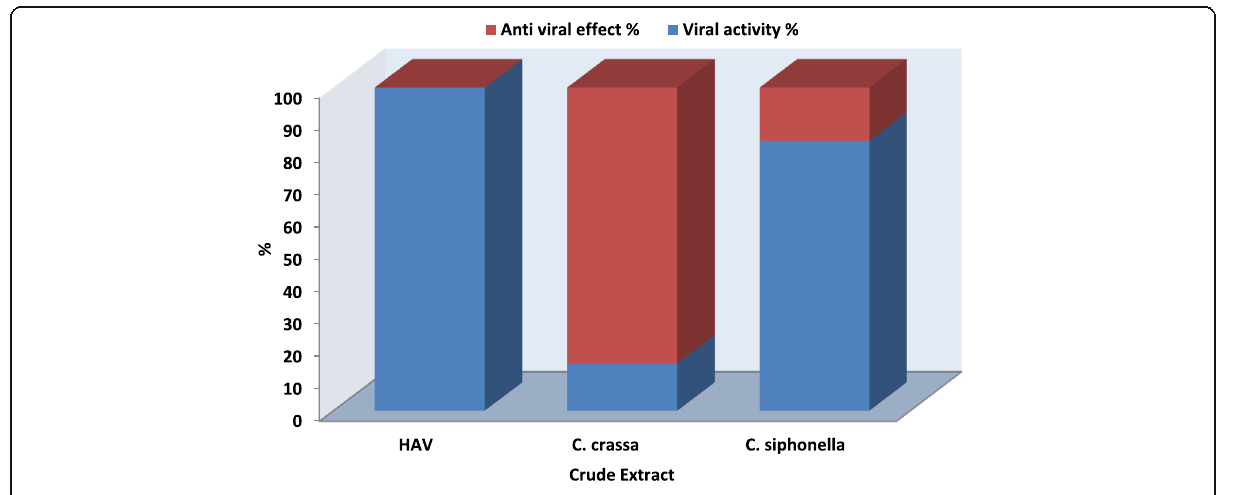
Fig. 4 Antiviral activity of crude sponge extracts against